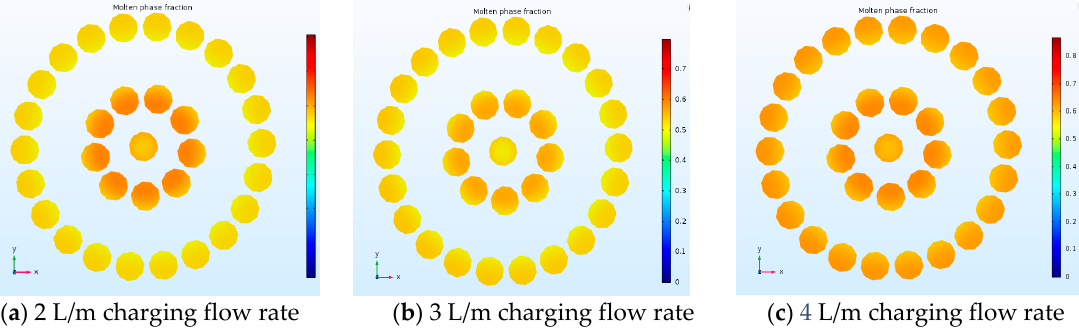
Figure 5. Melting fraction of phase change material (PCM) after charging period (9 h).